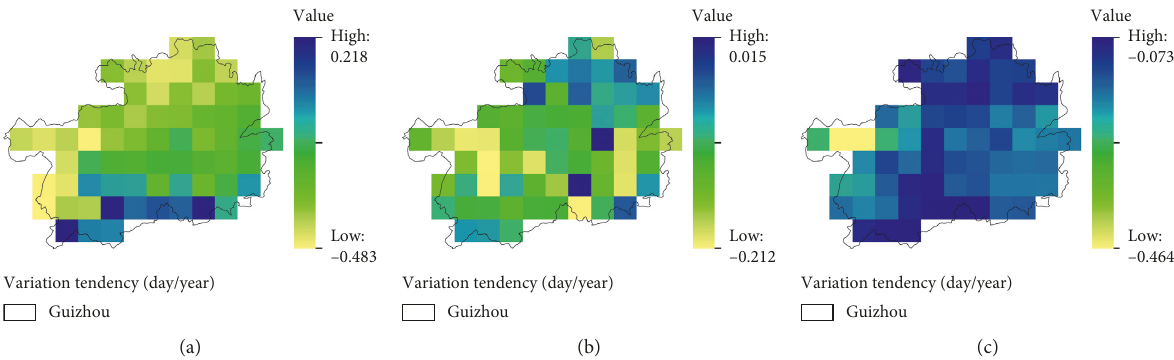
Figure 14: Distribution of the change rate of total days in crop growth period: (a) winter wheat, (b) summer maize, and (c) rice.